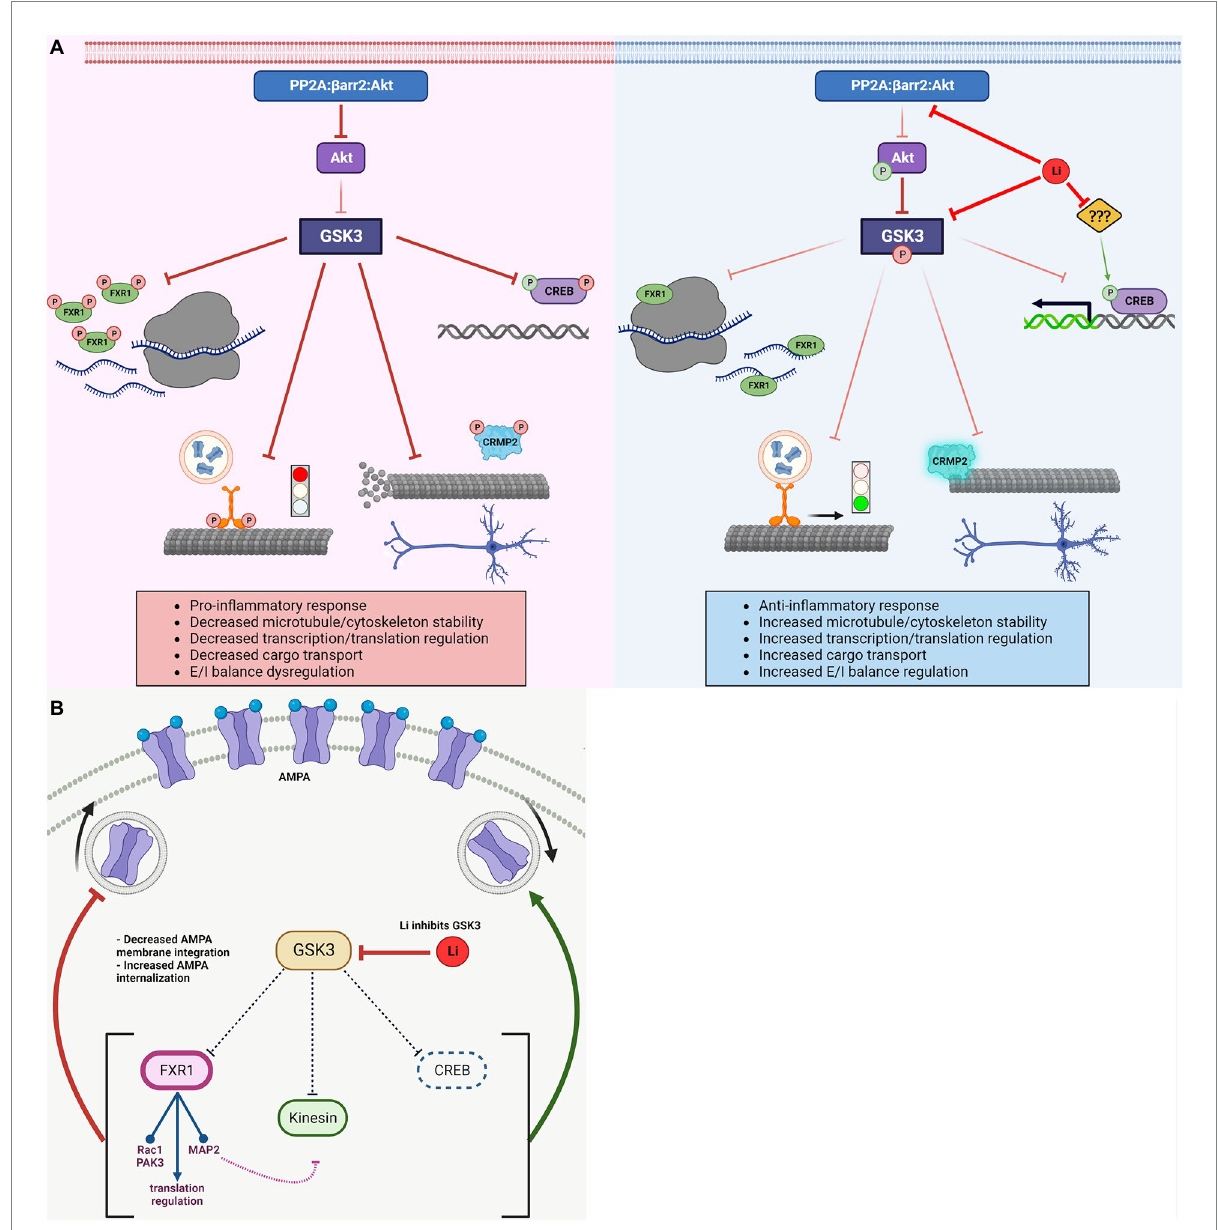
FIGURE 3 Regulation of GSK3 substrates and associated biological effects. (A) Activated GSK3 results in: decreased FXR1 mediated translational regulation, halted Kinesin and dissociated cargo, depolymerizing microtubule due to detached CRMP2, and inhibition of CREB-dependent transcription. Lithium inactivates GSK3 (directly and indirectly) resulting in: increased FXR1 mediated translation regulation, Kinesin mobility and delivery of cargo, CRMP2 association with (and increased stability of) microtubules, and activation of CREB-dependent transcription. Lithium has other targets, which may regulate CREB activity independently of GSK3. (B) GSK3 has various reported roles in regulating AMPA receptor trafficking and/ or cell surface expression via modulation of different substrates. FXR1 decreases surface AMPA expression by regulating translational of AMPA receptor subunits mRNAs directly (mRNA, ribosomes) or indirectly by regulating expression of signaling molecules (Rac1, PAK3, and MAP2) involved in the regulation of receptor trafficking. CREB activity increases surface AMPA. Active kinesin also increases surface AMPA, but might be impeded by regulation of MAP2 and Rho GTPases by FXR1 (e.g., decreased MAP2 leads to unstable microtubules, preventing kinesin movement). Net result could depend on the relative activation/inhibition of specific pathways. GSK3, glycogen synthase kinase-3; FXR1, fragile X related protein 1; CRMP2, collapsin response mediator protein 2; CREB, cAMP response element-binding protein; Li, lithium; AMPA, α -amino-3- hydroxy-5-methyl-4-isoxazolepropionic acid; PAK3, p21-activated kinase 3; and MAP2, microtubule-associated protein